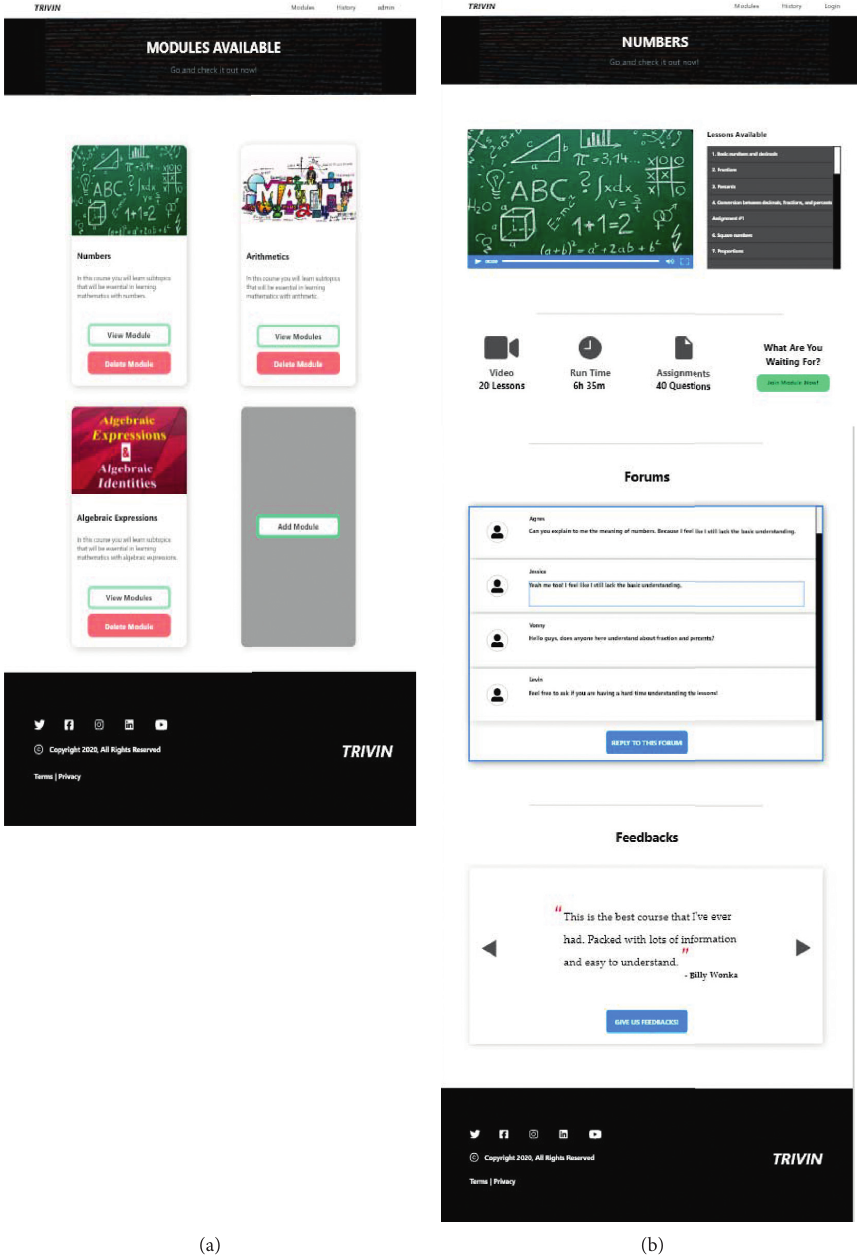
Figure 5: (a) Module page for admin UI and (b) module detail page UI